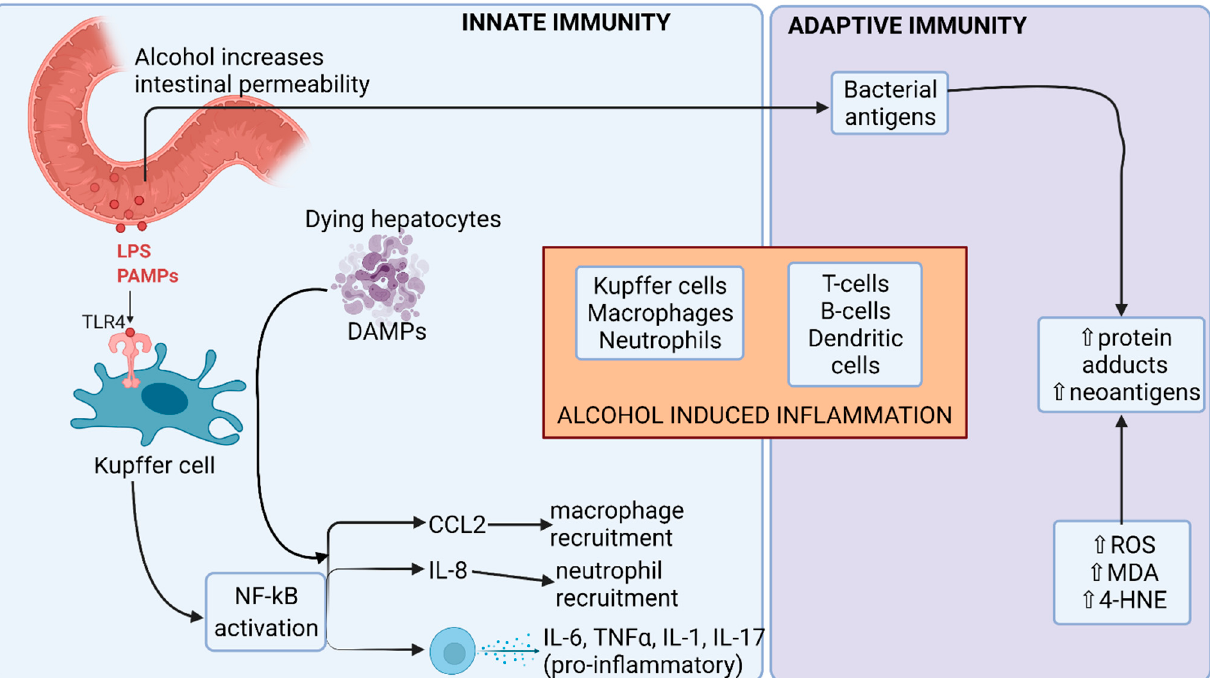
Figure 4. Alcohol-induced inflammation. Alcohol exerts its effects on both the innate and adaptive immunity. Alcohol not only induces enteric dysbiosis, but also increases intestinal permeability. Pathogen-associated molecular patterns (PAMPs) such as lipopolysaccharide (LPS) interact with TLR4 receptor on Kupffer cells and produce proinflammatory cytokines and chemokines via the NF- κ B pathway, leading to liver inflammation. Acetaldehyde induces structural changes in various proteins and generates neoantigens, which elicit an adaptive immune response and contribute to liver inflammation. CCL2: C-C motif chemokine ligand 2; DAMPs: damage-associated molecular patterns; 4-HNE: 4-hydroxynonenal; IL: interleukin; MDA: malondialdehyde; NF- κ B: nuclear factor kappa B; ROS: reactive oxygen species; TLR4: toll-like receptor 4; TNF α : tumor necrosis factor alpha; ↑ : increased; ↓ : decreased. Image created at biorender.com (accessed on 20 August